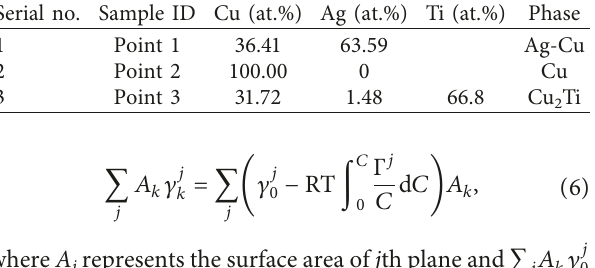
Figure 5: (a) XRD pattern of Ag-Cu-Ti- x CeO 0.1wt%. (f) EDS analysis of different phases in (b) and (d). Table 2: EDS data of different phases in Figures 5(b)–5(d). Serial no. Sample ID Cu (at.%) Ag (at.%) Ti (at.%)